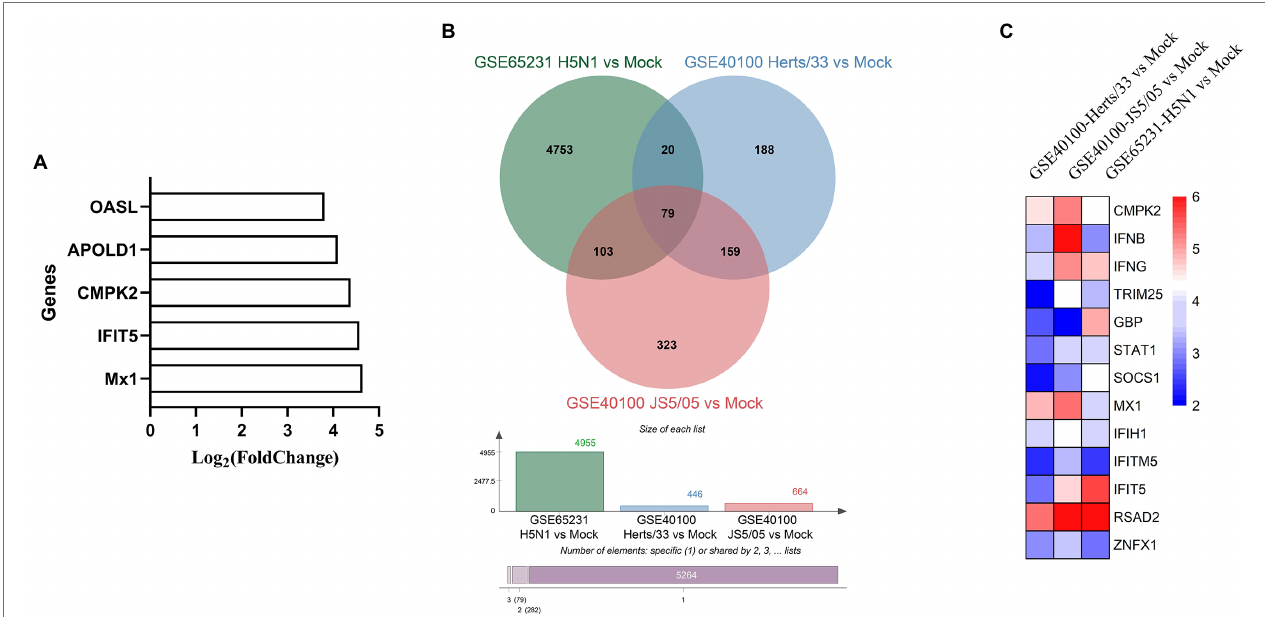
FIGURE 1 | Differential expression analysis of CMPK2 in response to virus infection based on GEO database. (A) Histogram showing the top 5 upregulated genes according to a previous study in NDV-infected DF-1 cells. (B) Venn plot showing common upregulated genes with significant differential induction (Herts/33-, JS5-, or H5N1-infected versus uninfected). (C) Heat map showing fold change values after AIV H5N1 and NDV Herts/33 and JS5/05 infection of genes related to IFN and ISGs among the 79 common upregulated genes in (B)